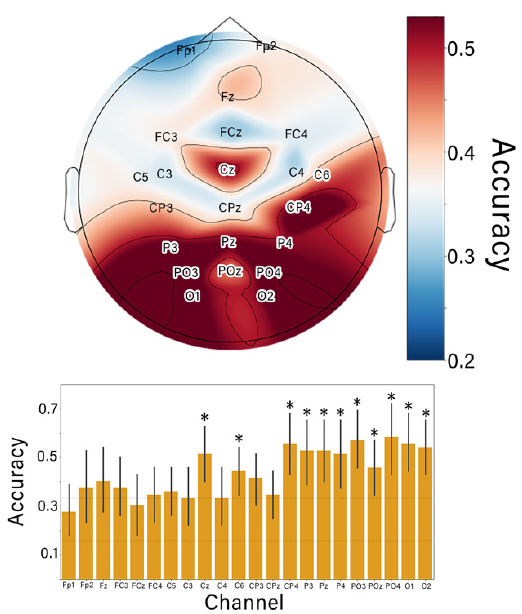
Figure 5. Scalp distribution of the average single-channel classification accuracy and accuracy values (an average for all participants and cross-validation trials). The colors represent the mean accuracy for single-channel classifications conducted offline, with red corresponding to high scores. The bars define the mean values of the offline estimated single-channel accuracy; the error bars show 95% confidence intervals. Asterisks indicate significant differences from the chance level 0.33 (Wilcoxon sign rank test with Bonferroni correction).